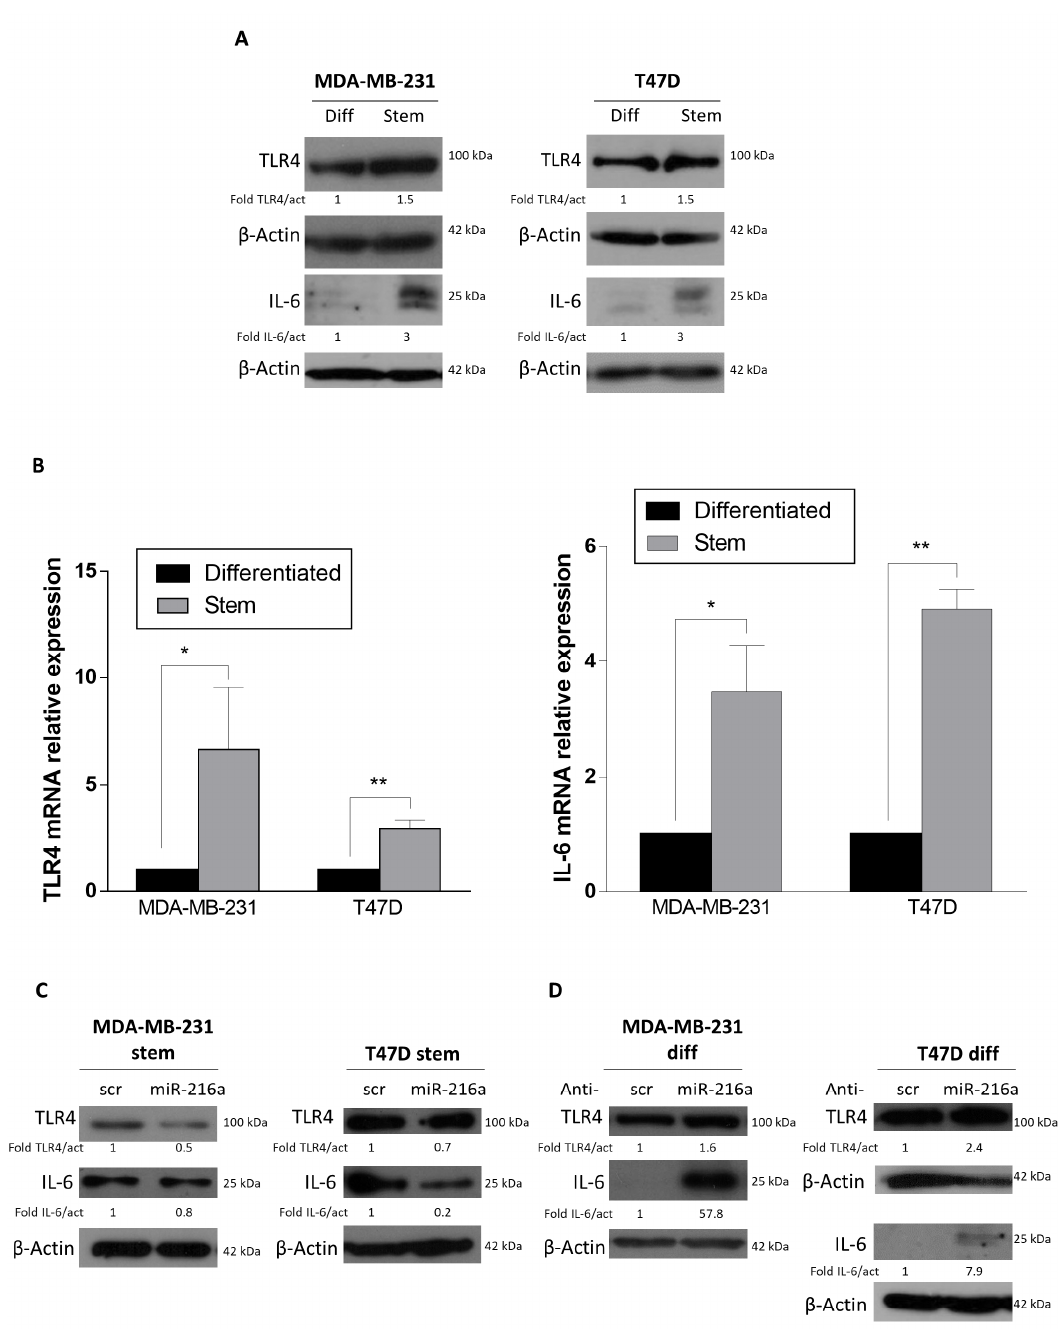
Figure 4. Toll-like receptor 4 (TLR4) is targeted by miR-216a-5p and regulates interleukin 6 (IL-6) levels. ( A , B ) TLR4 and IL6 protein and mRNA levels are higher in MDA-MB-231 and T47D stem cells compared to di ff erentiated cells, as assessed by Western blotting and qRT-PCR, respectively. ( C ) MiR-216a overexpression induces a decrease in TLR4 and IL6 protein expression in MDA-MB-231 and T47D stem cells. ( D ) Conversely, by downregulating miR-216a, TLR4 and IL6 protein expression are increased. Significance was calculated using Student’s t-test. *, p < 0.05; **, p < 0.01. In ( C ) the blots representing TLR4 and IL-6 for MDA-MB-231 and T47D are from the same gel of Figure 2D. In ( D ) the blots representing TLR4 and IL-6 for MDA-MB-231 and TLR4 for T47D are from the same gel of Figure